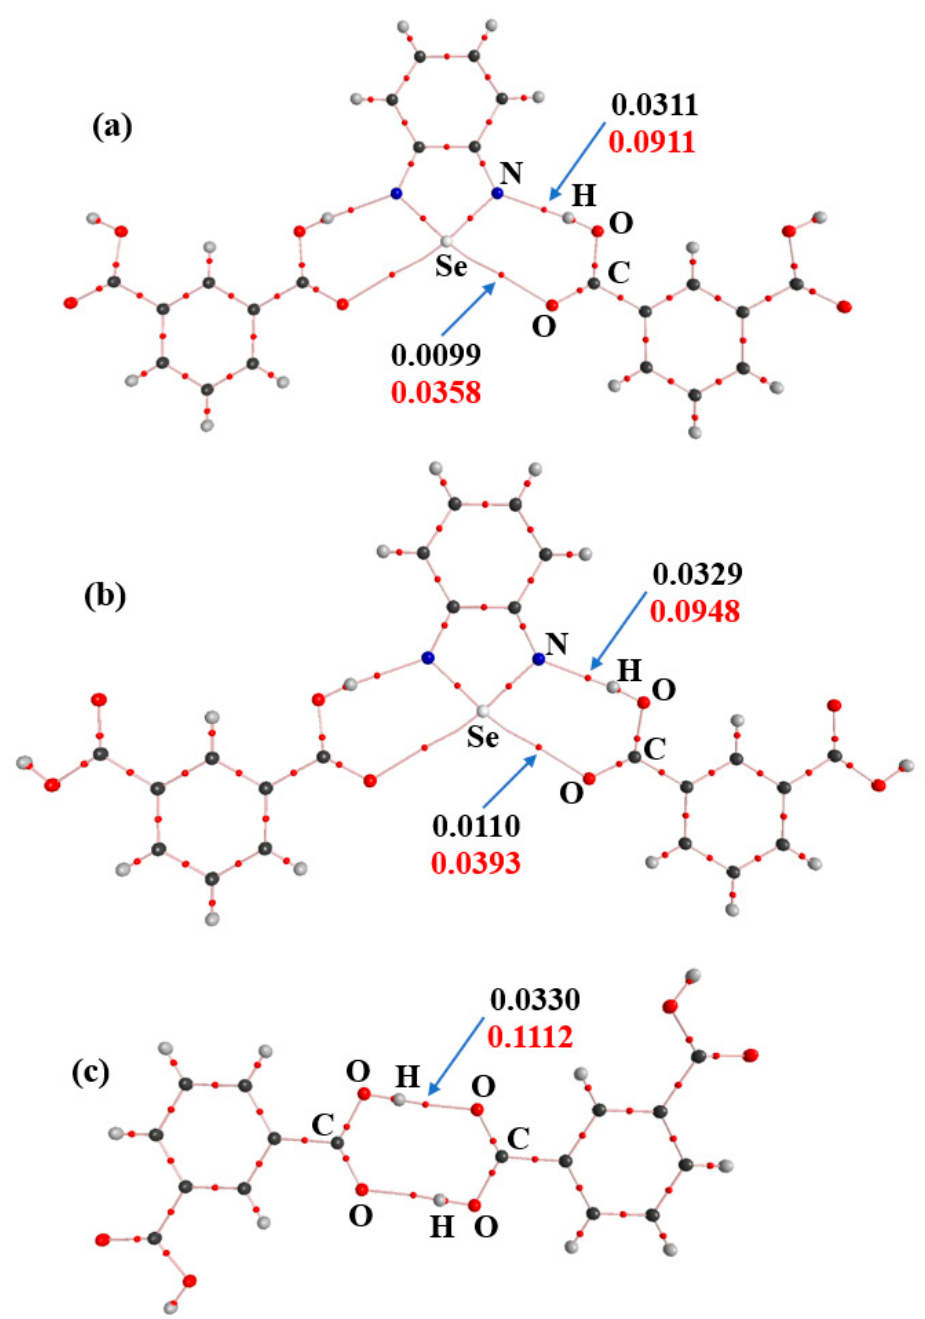
Figure 8. The molecular graphs for the complexes in cocrystals 1 ( a ) and 2 ( b , c ). For clarity purposes, only the bond critical points (small red dots) are shown. The black numbers (in au) are the electron densities, and the red numbers (in au) are the Laplacians of the electron densities.